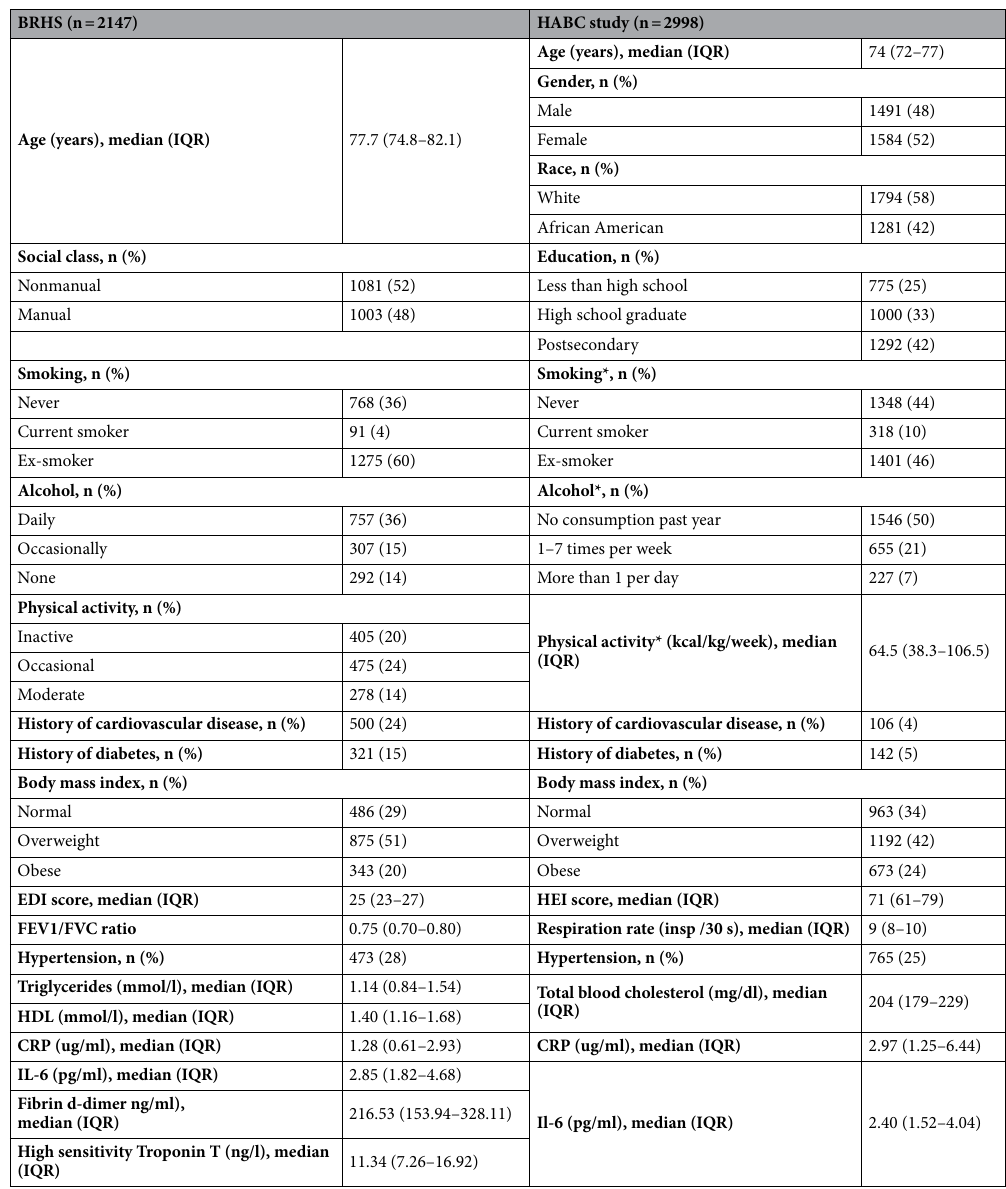
Table 1. Population characteristics in the British Regional Heart Study (BRHS) and the Health, Aging, and Body Composition (HABC) Study. EDI elderly dietary index, HEI healthy eating index. *Measured at Year 1